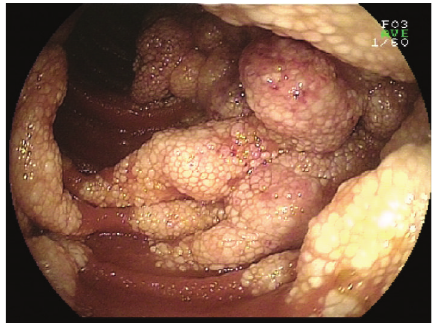
Figure 4: Jejunal hamartoma, resected specimen.